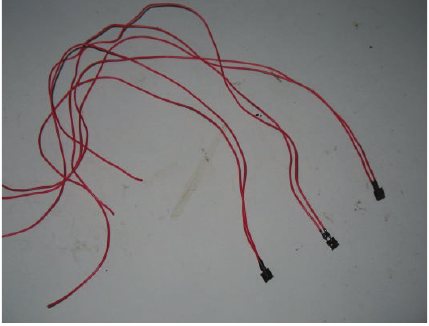
Figure 2: PZT impedance sensors covered with asphalt